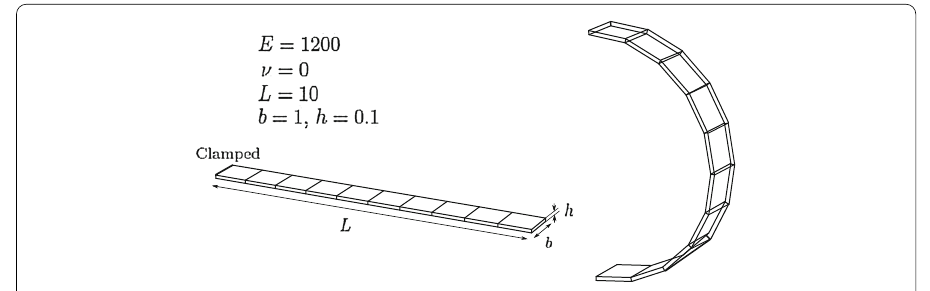
Fig. 2 A cantilever beam subjected to an end moment modeled with regular mesh 10 × 1 × 1 and his deformed